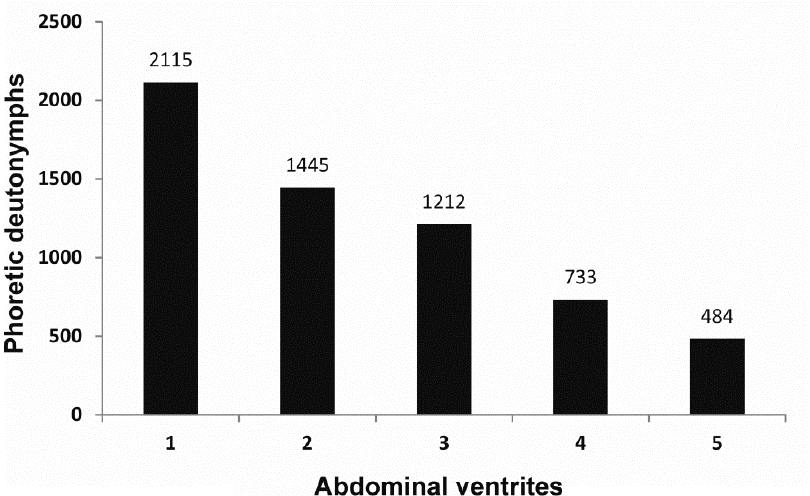
Figure 7. Number of phoretic deutonymphs of Trichouropoda sociata attached to the abdominal ventrites of Plagionotus detritus .